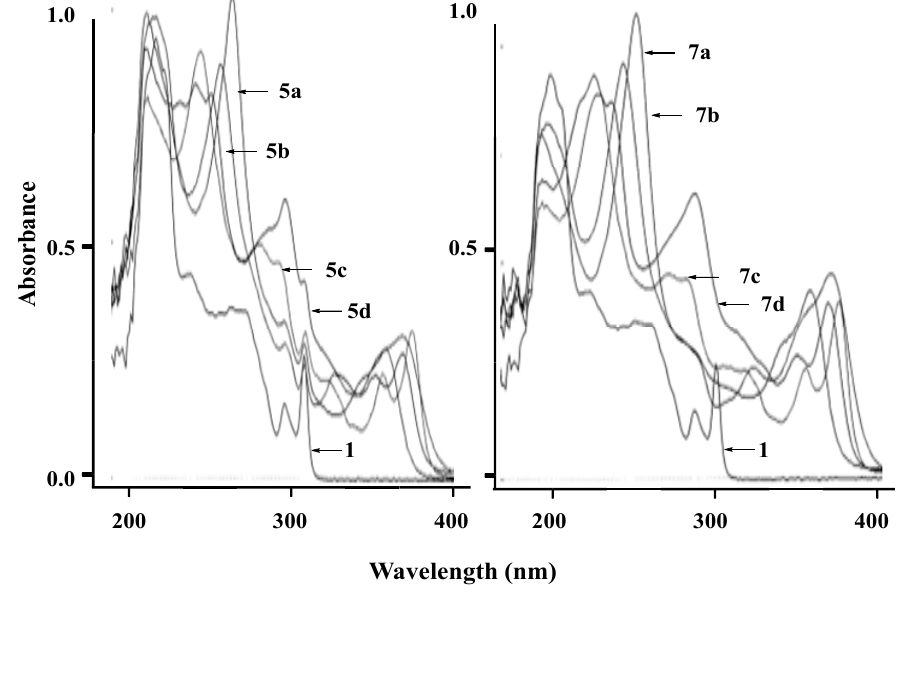
Figure 2. UV absorption spectra of 1 , 5 and 7 in 95% EtOH (1.0 × 10 − 5